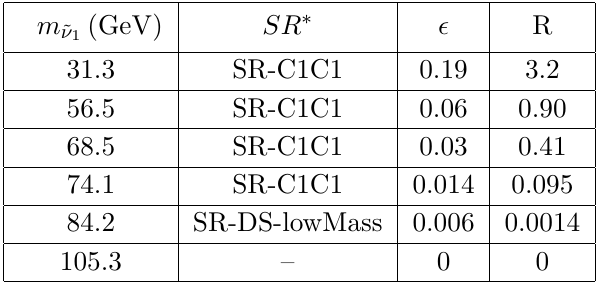
signal in [125] for six parameter T